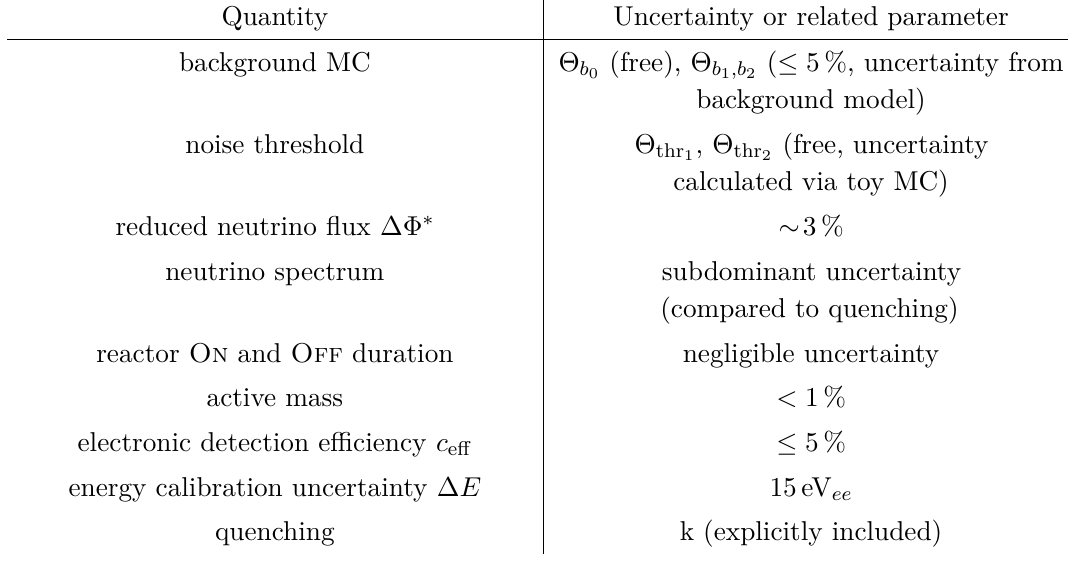
Table 3 . Overview of the quantities entering the likelihood and their corresponding uncertainties. For details and further information see main